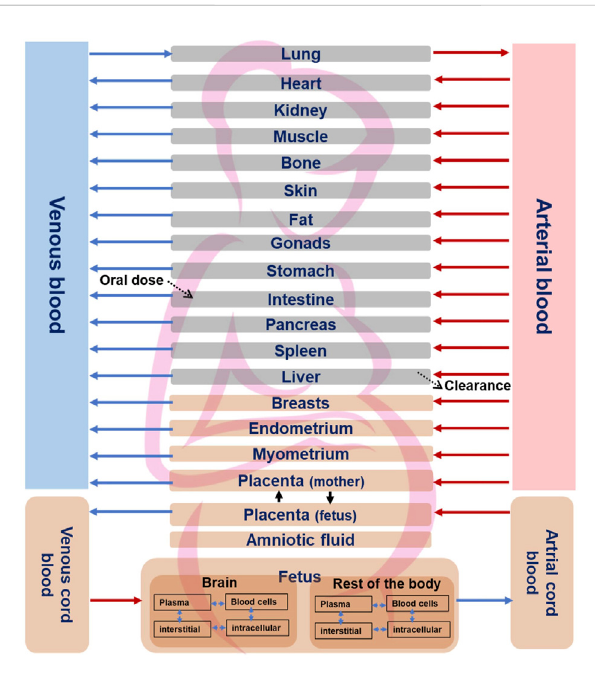
FIGURE 1 Structure of the fetal-maternal PBK model for CPF. Pregnancy- speci fi c compartments are depicted in orange. The four sub- compartments (blood cells, plasma, interstitial, and intracellular) for CPF distribution are shown for brain and rest of the fetal body sub-compartments. Solid lines indicate blood fl ow process, dotted lines indicate transport via passive